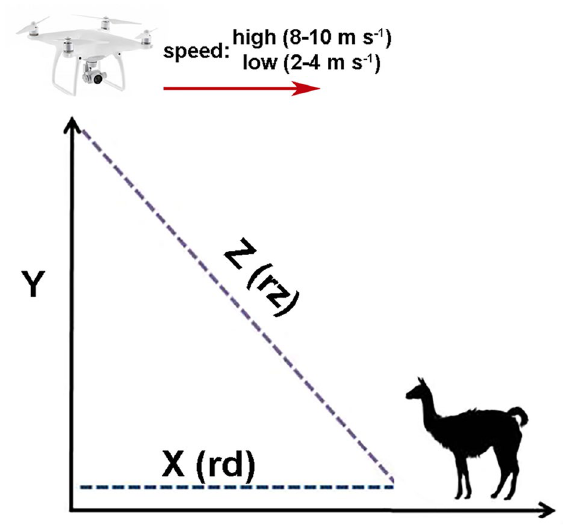
Figure 1. Flight plan for approaching guanacos at La Payunia Reserve. The drone was launched at least 300 m away from the group and flew towards it at constant height and speed. We combined low (2–4 m s −1 ) and high (8–10 m s −1 ) speeds with low and high heights (60 and 180 m AGL, respectively). Flight distance components: Y = flight height; X (rd) = distance between the guanaco group and the drone’s projection to the ground, Z (rz) = straight line distance from the guanaco group to the drone. rd = horizontal reaction distance; rz = diagonal reaction